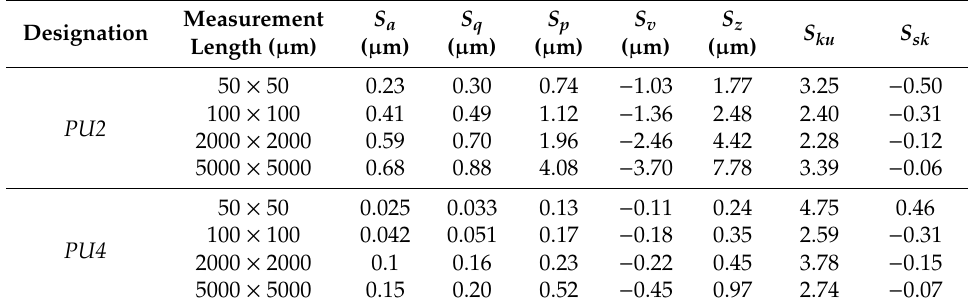
Table 2. Surface roughness parameters calculated from atomic force microscopy (AFM) and 3D surface profilometer.